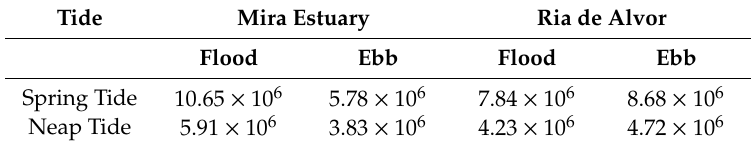
Table 4. Tidal prism (m 3 ) computed at the mouth channel section for Mira Estuary and Ria de Alvor. Tide Mira Estuary Ria de Alvor Flood Ebb Flood Ebb Spring Tide